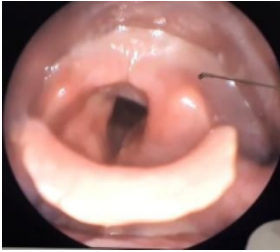
Figure 15. Mass over left cricoarytenoid joint causing fixation of left hemilarynx